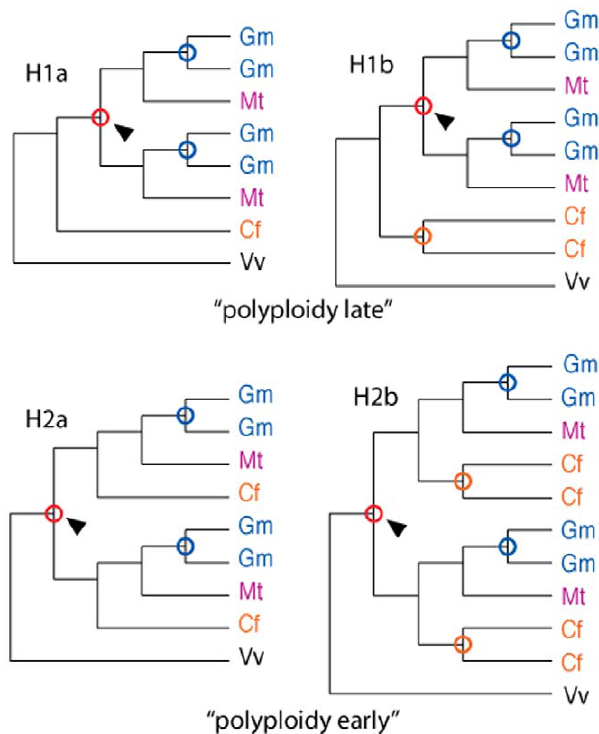
Figure 2. Models of speciation and polyploidy timings. Each figure represents a gene tree that would be expected, assuming no gene losses or additional gains, under the following models: H1 = polyploidy after the Chamaecrista – papilionoid split; H2 = polyploidy before the Chamaecrista – papilionoid split; ‘‘a’’ variants = no independent polyploidy in the Chamaecrista lineage; ‘‘b’’ variants = independent polyploidy in the Chamaecrista lineage.